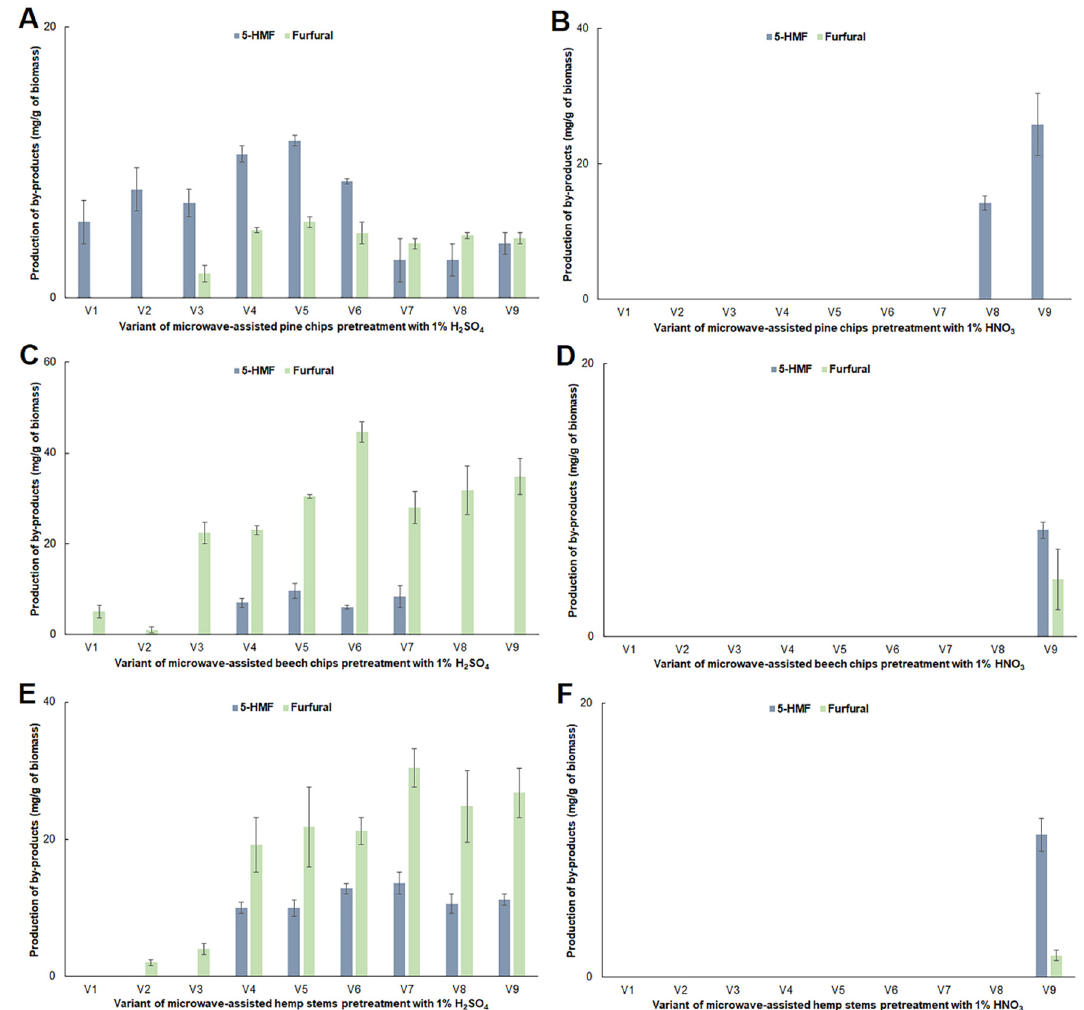
Figure 3. Concentrations of 5-hydroxymethylfurfural (5-HMF) and furfural after microwave pretreatment in experimental variants (( A )—pine chips, 1% v / v H 2 SO 4 ; ( B )—pine chips, 1% v / v HNO 3 ; ( C )—beech chips, 1% v / v H 2 SO 4 ; ( D )—beech chips, 1% v / v HNO 3 ; ( E )—hemp stems, 1% v / v H 2 SO 4 ; ( F )—hemp stems, 1% v / v HNO 3 ).